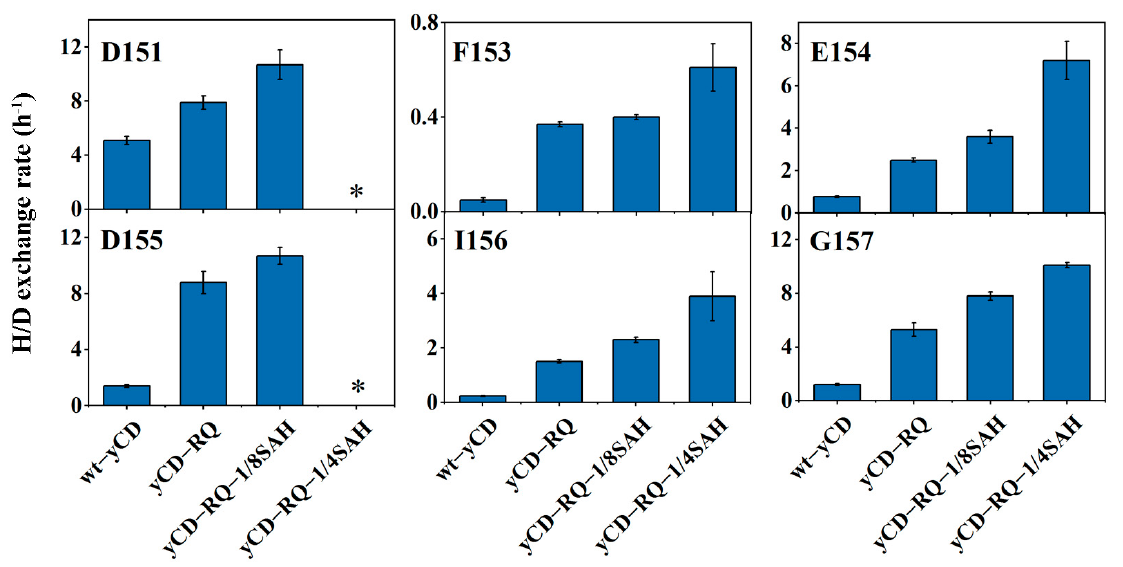
Figure 7. Backbone amide H/D exchange rates of residues in the C-terminal helix of wt-yCD, yCD-RQ, yCD-RQ-1/8SAH, and yCD-RQ-1/4SAH complexed with the TSA. * The exchange rate is faster than the detection limit (~15 h − 1 ). The error bars are standard deviation from duplicate experiments.